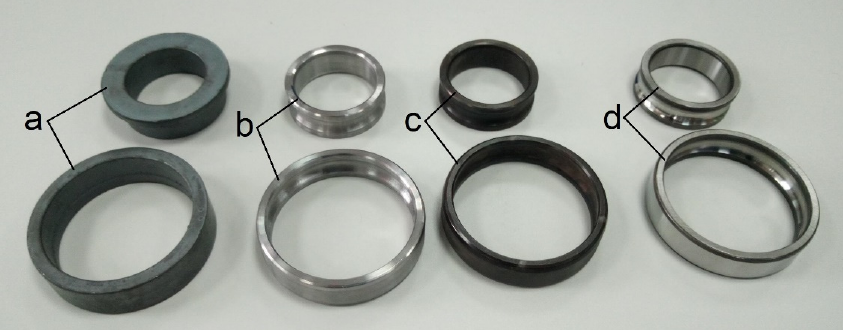
Figure 1. Type 6308-2z rolling bearing rings after successive operations of the technological process: ( a ) rings after forging, ( b ) rings after turning, ( c ) rings after heat treatment, ( d ) rings after grinding.